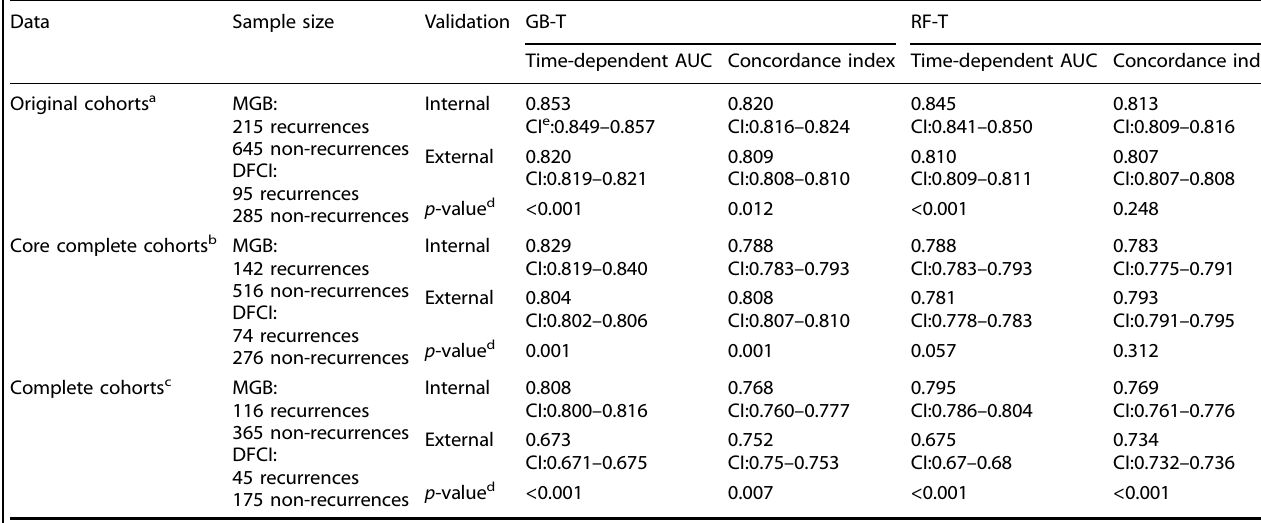
Table 3. Time-to-event melanoma recurrence prediction by GB-T and RF-T models.